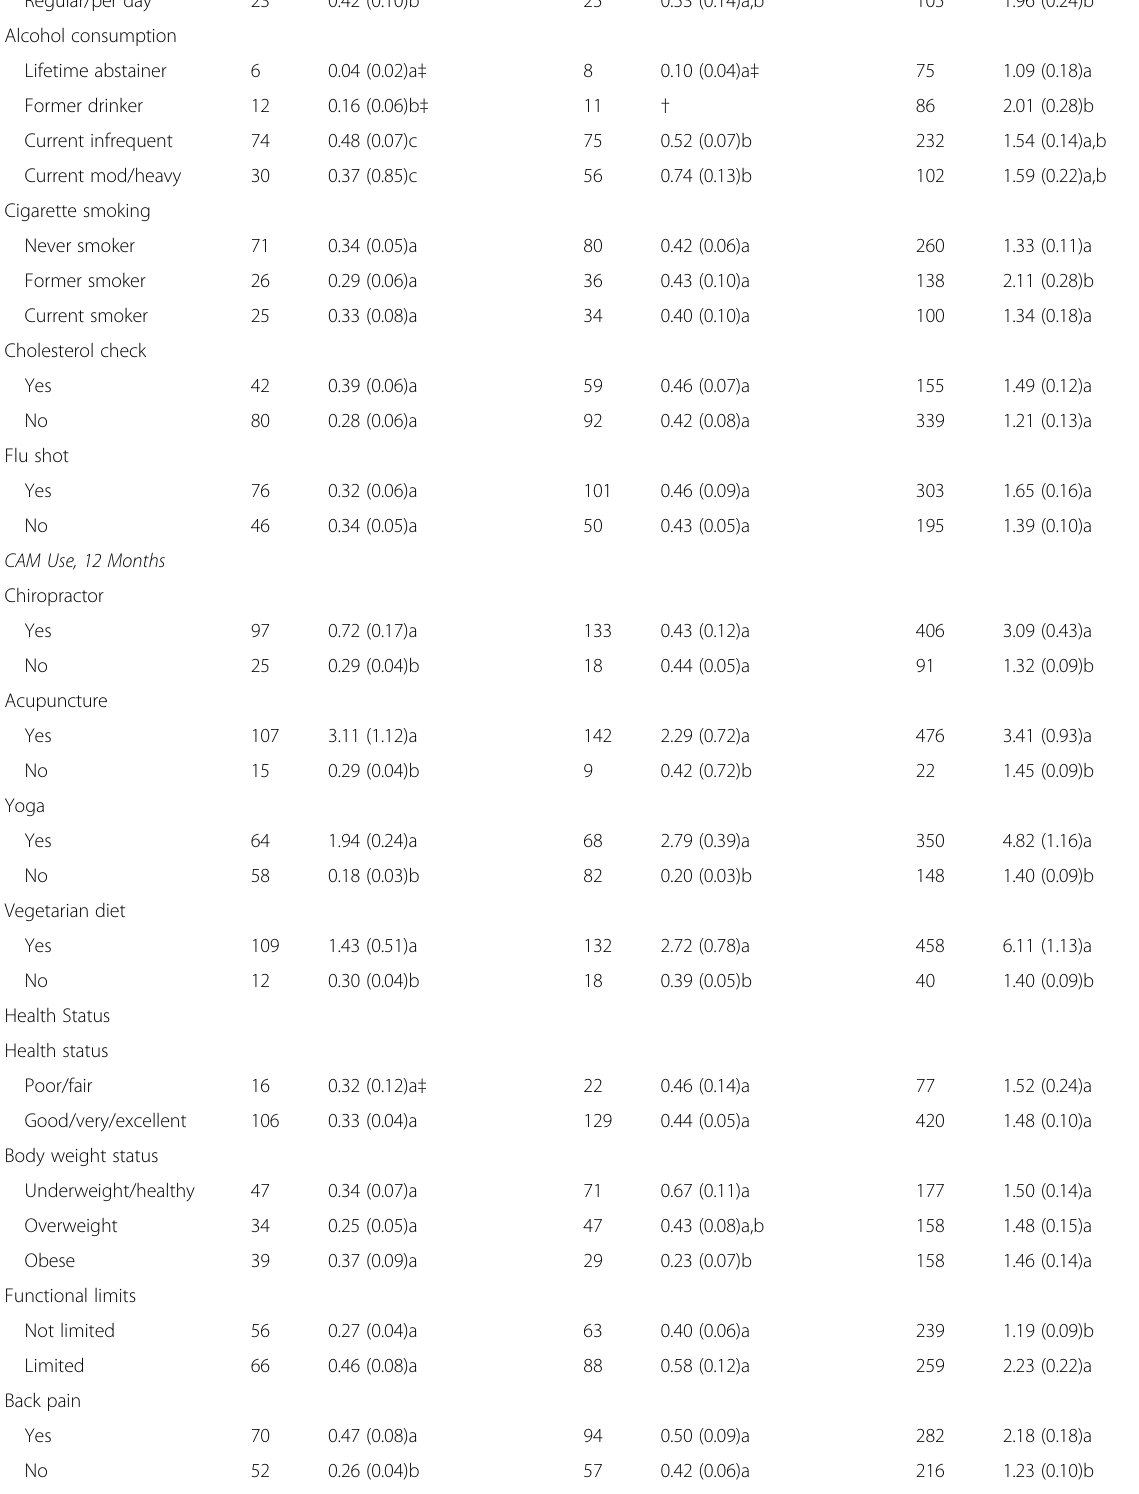
Table 2 Prevalence of meditation use by select user characteristics, exclusive use of one practice during previous 12 months 1